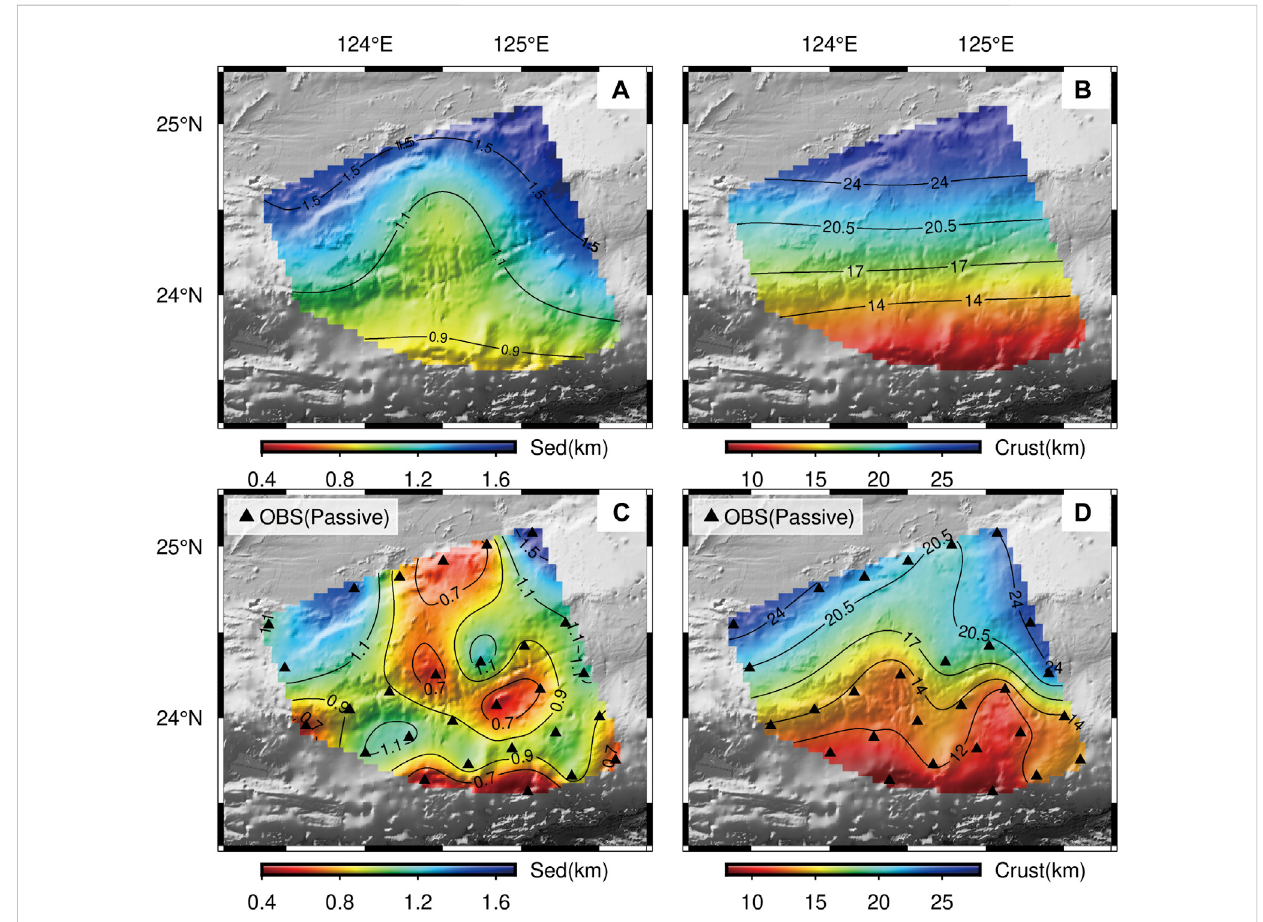
FIGURE 9 (A) and (B) DistributionmapofsedimentarylayerandcrustalthicknesswithCRUST1.0model(Laskeetal.,2012),respectively. (C) and (D) Distribution map of sedimentary layer and crustal thickness obtained by sequential H- κ